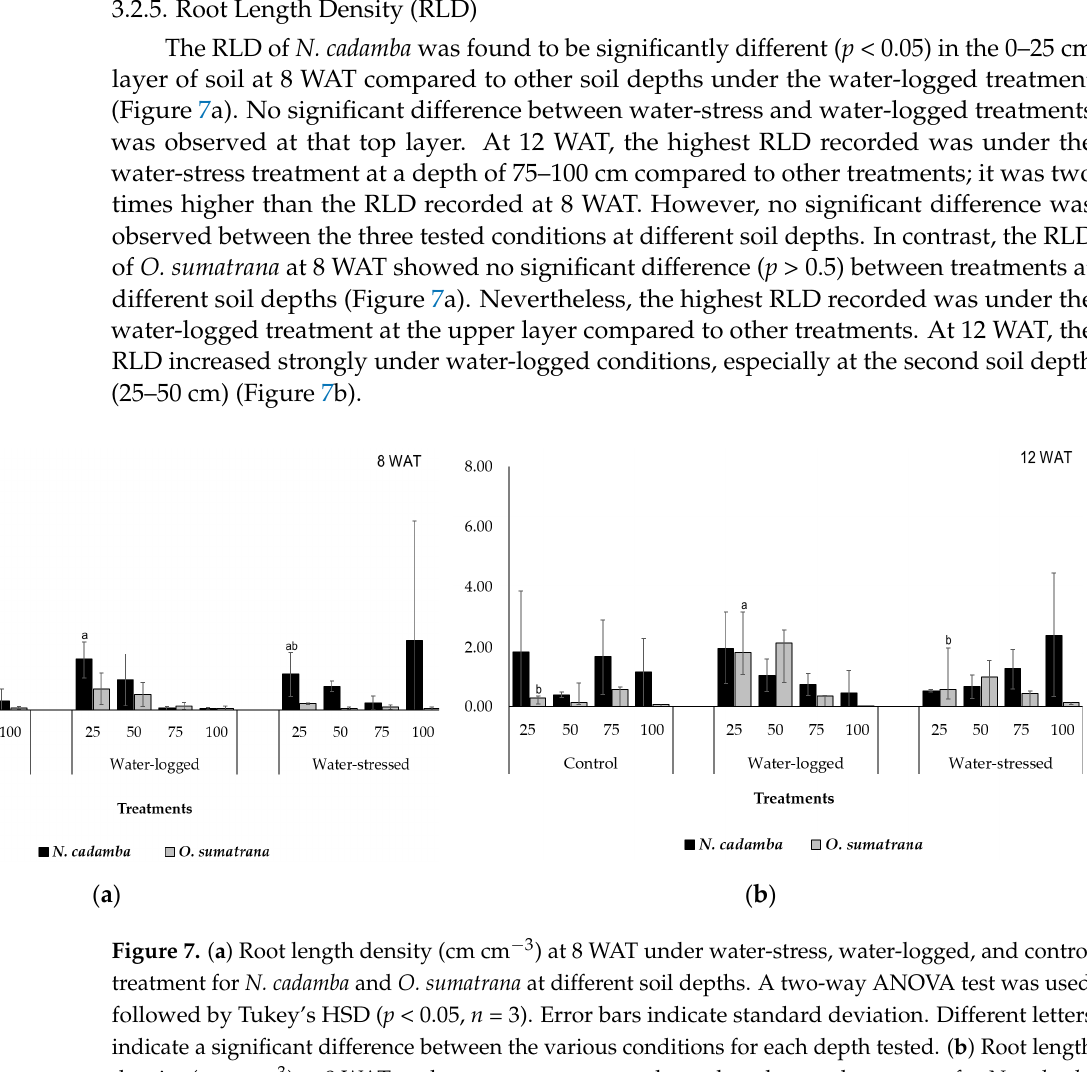
Figure 6. ( a ) Specific Root Length (cm cm − 3 ) at 8 WAT under water-stress, water-logged, and control treatment for N. cadamba and O. sumatrana at different soil depths. A two-way ANOVA test was used, followed by Tukey’s HSD ( p < 0.05, n = 3). Error bars indicate standard deviation. Different letters indicate a significant difference between the various conditions for each depth tested. ( b ) Root length density (cm cm − 3 ) at 12 WAT under water-stress, water-logged, and control treatment for N. cadamba and O. sumatrana at different soil depths. A two-way ANOVA test was used, followed by Tukey’s HSD ( p > 0.05, n = 3). Error bars indicate standard deviation.